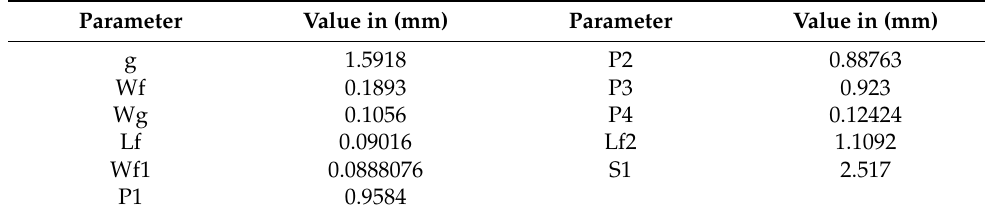
Figure 7. Four elements of the transmitter subarray where each of the two elements share a common feed via a T-junction power divider. Table 1. The parameters of the proposed transmitter antenna elements.